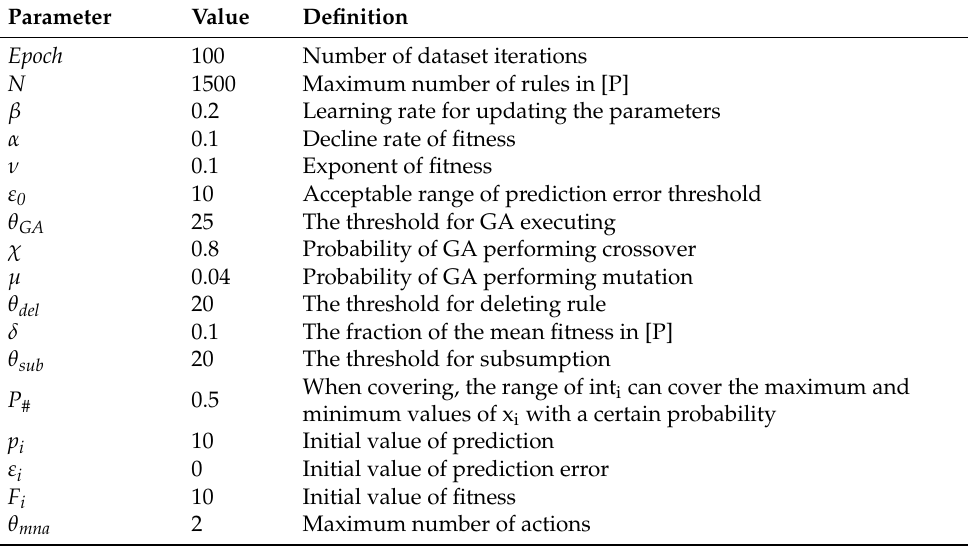
Table 3. Parameter setting.